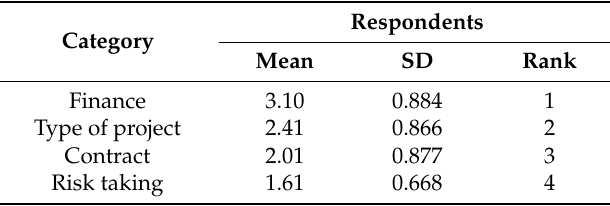
Table 2. Factors influencing a company’s project decision making in estimating